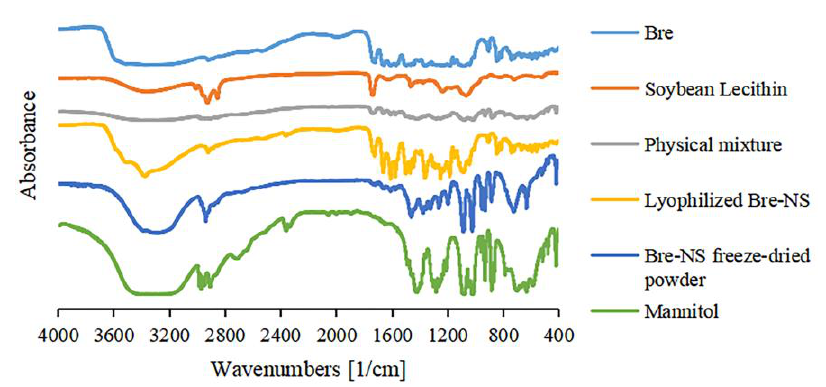
Figure 6. Fourier transform-infrared (FT-IR) spectrum of Bre, soybean lecithin, physical mixture, lyophilized Bre-NS, the Bre-NS freeze-dried powder and mannitol.